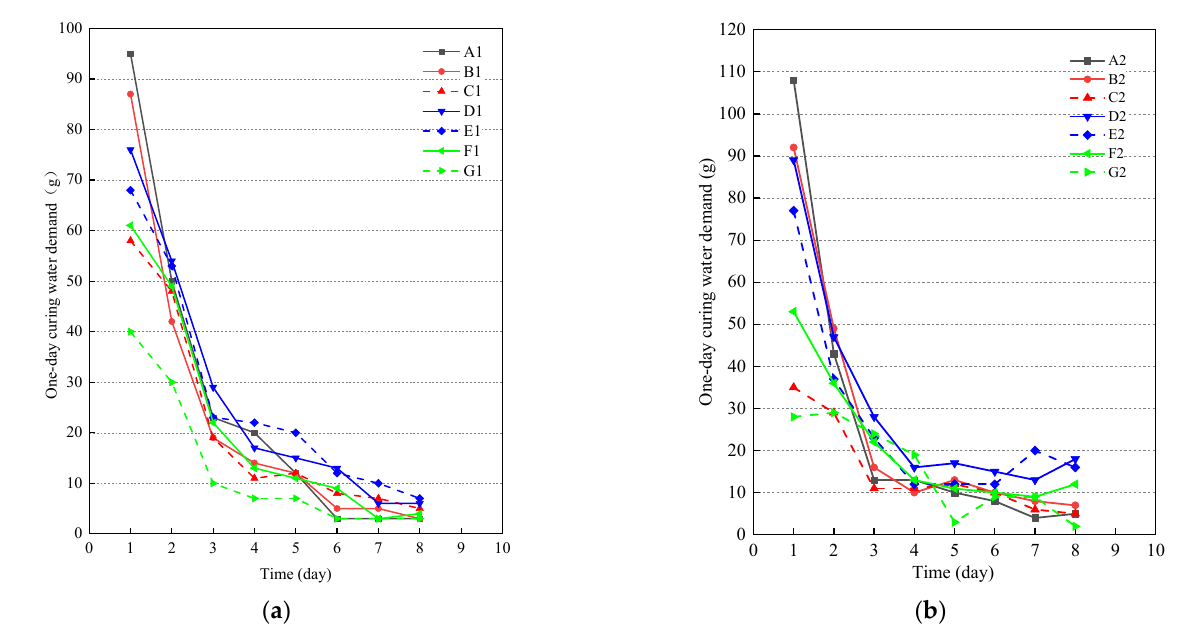
Figure 2. One ‐ day curing water demand of different mineral admixtures. ( a ) 0.35; ( b ) 0.45. Figure 2. One-day curing water demand of different mineral admixtures. ( a ) 0.35; ( b )